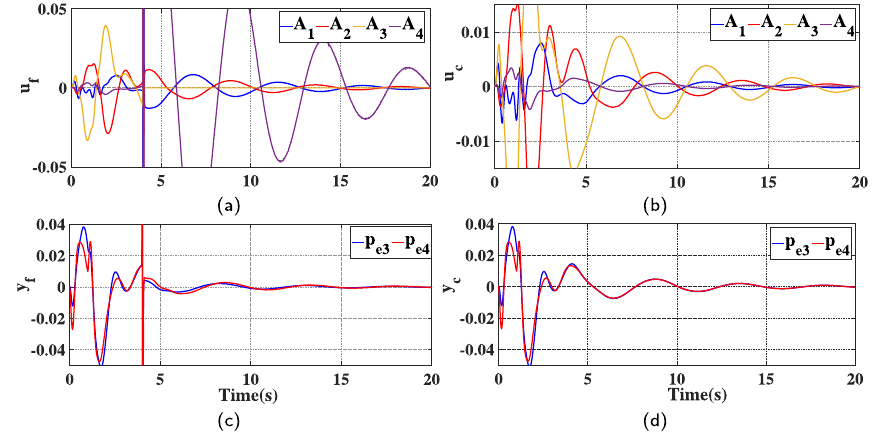
Fig. 7 System reconfiguration with actuators { A 1 , A 2 , A 4 } active on actuator fault at A 3 . a Actual input( u f ) to system; b Reconfigured control signal( u c ) as seen by controller at system input; c Actual feedback signal( y f ) showing effect of integration of RC at time of fault; d Reconfigured feedback signal( y